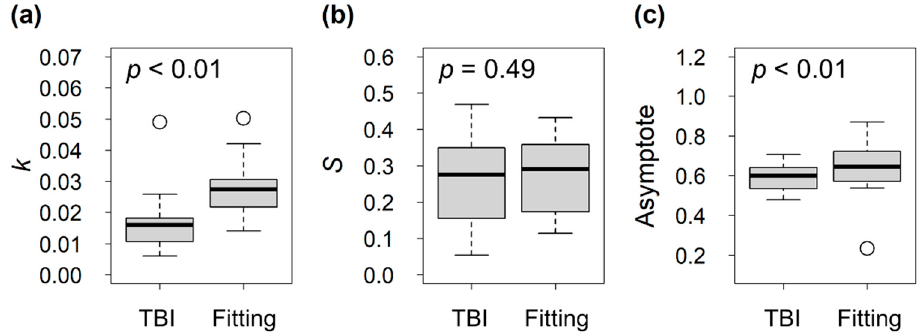
Figure 4. Comparisons of ( a ) k , ( b ) S , and ( c ) asymptote (i.e., 1 − a r ) obtained by the TBI approach and those obtained by fitting the asymptote model to the time series data. Statistical significances were examined using a linear mixed-effects model.